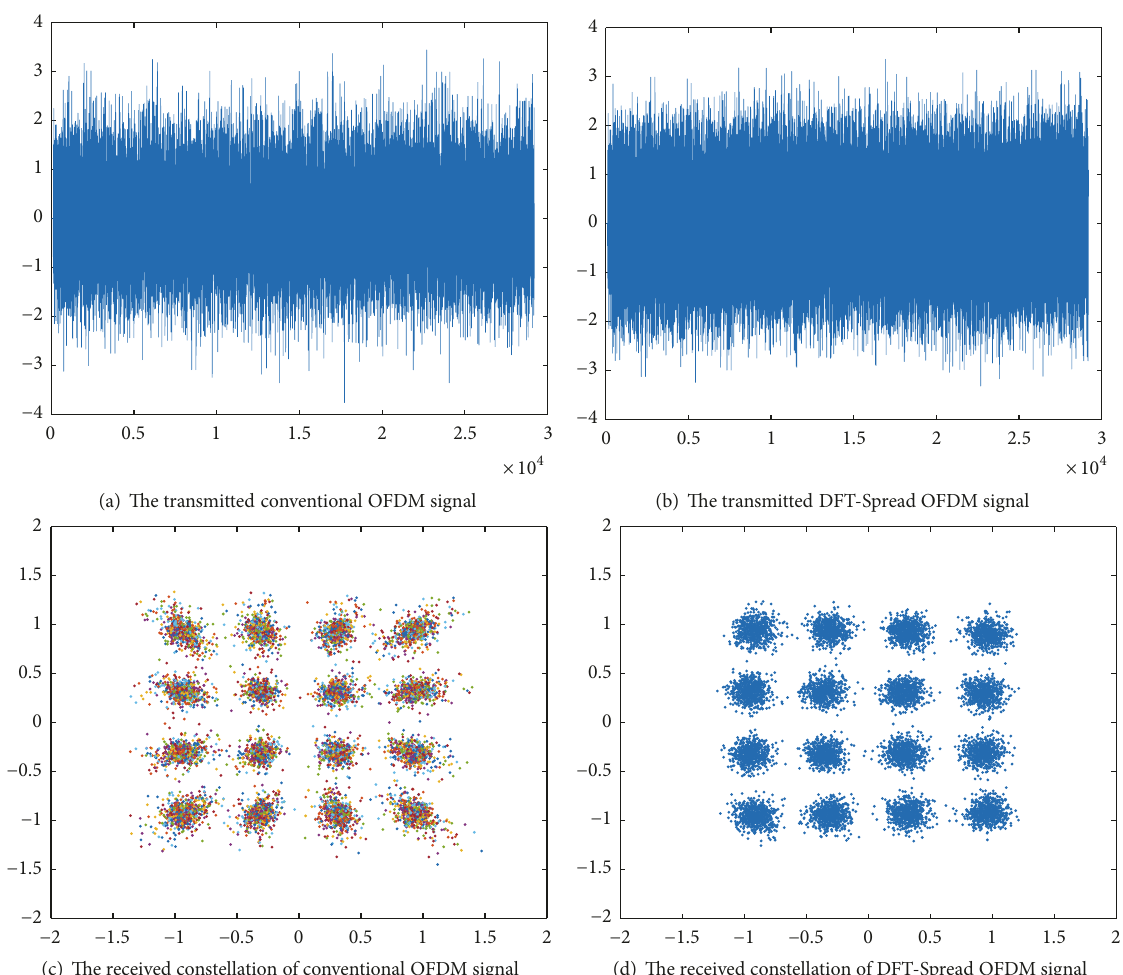
Figure 4: The conventional OFDM signal and the DFT-Spread OFDM